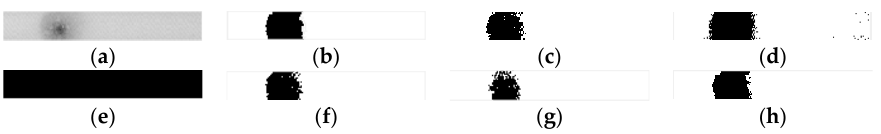
Figure 10. Image22 and its segmentation results: ( a ) #image22, ( b ) ground-truth, ( c ) Otus, ( d ) MRCUT, ( e ) EITMIS, ( f ) NSWCC, ( g ) IT2FSWCC, ( h ) FSEFTISRI.